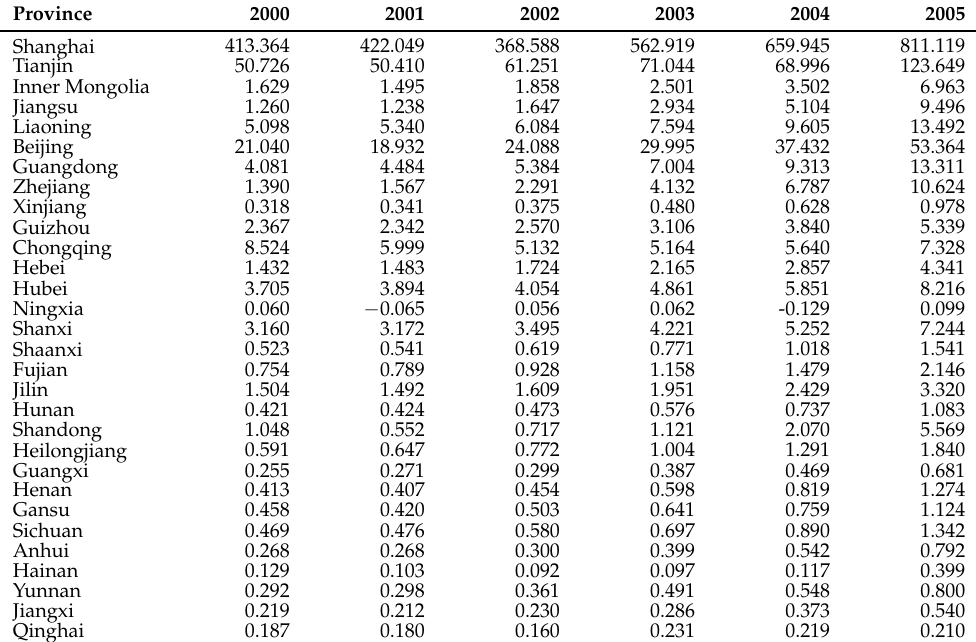
Table A7. The intra-provincial carbon inequality estimation results of original carbon emission data based on a 4-year rolling window for 30 provinces in China from 2000 to 2005.